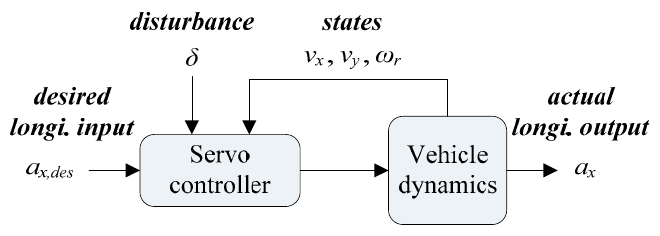
Figure 3. Disturbance decoupling via a state-feedback.